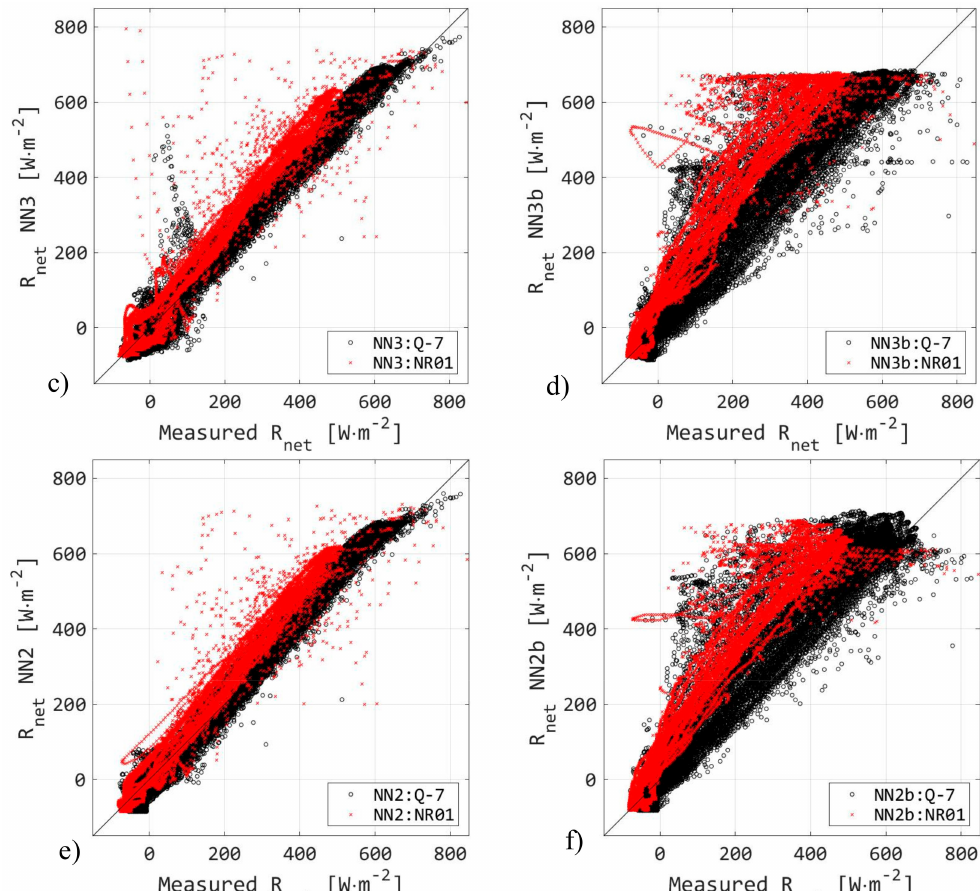
Figure 8. Correspondence between measured ( x -axis) and NN model of net radiation. The black markers indicate the full-season record of comparison (with Q-7 measurements) and the red markers indicate the short period of record around the 2017 solar eclipse (NR01 measurements). Results using NN5 are shown in 8( a , b ). 8( c – f ) show results from NN3, NN3b, NN2, and NN2b, respectively, including comparisons against both Q-7 sensor (black) and NR01 (red